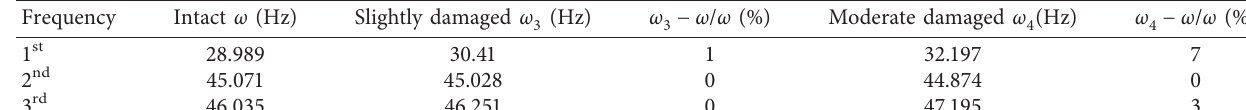
Table 3: First three natural frequencies of the vertically damaged polymer cutoff wall.